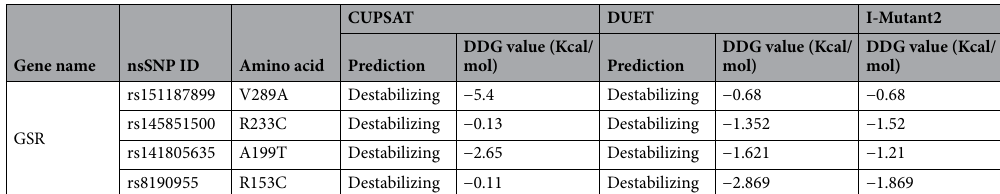
Table 2. List of damaged nsSNPs and affected amino acids their prediction, DDG values after mutation by using I-Mutant, CUPSAT and